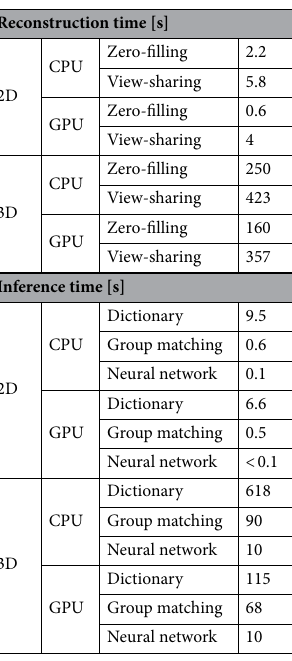
Table 4. Reconstruction and inference times. Measurements were performed on an Intel Xeon processor E5-2600 v4 (48 CPU cores) equipped with a NVIDIA Tesla K80 GPU. The inference times are compared between exhaustive grid search (dictionary matching), fast group matching, and neural network. 2D results are reported for a single slice of the spiral